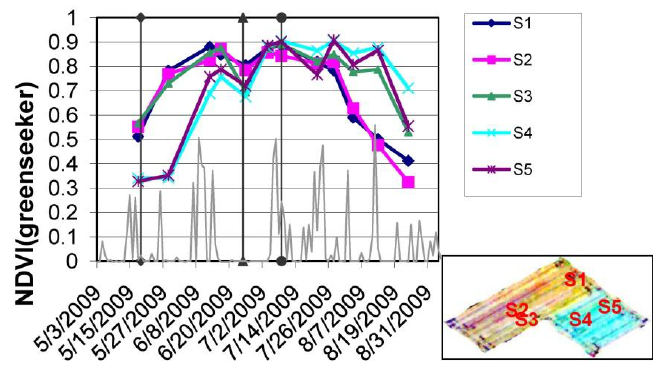
Figure 1. Development of normalized difference vegetation index (NDVI) from time-series of measurements with Greenseeker sensor in potato parcel and comparison with rainfall data from nearby meteorological sensor network. The timing of agricultural management practices (e.g., irrigation and fertilization) is also indicated in the figure. The inset shows the sample locations for the Greenseeker sensor within the parcel. The variation in colours represent a composite image indicating NDVI at different stages over the growing season: red: 13 June; green: 9 July; blue: 29 July